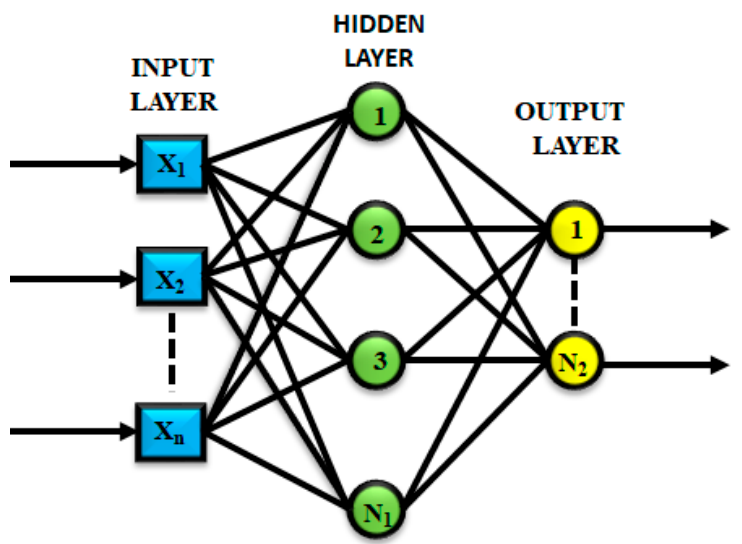
Figure 6. Artificial neural network (ANN) topology.